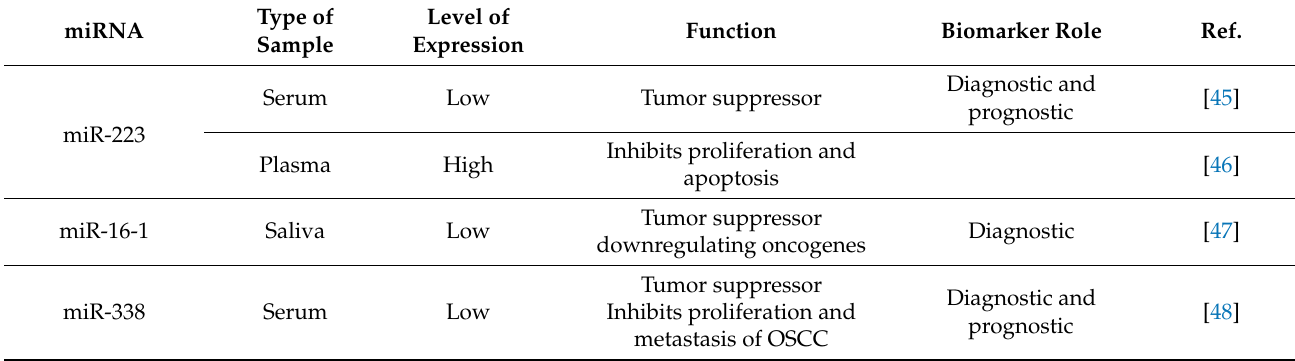
Table 1. Dysregulated miRNAs and their function in oral cancer